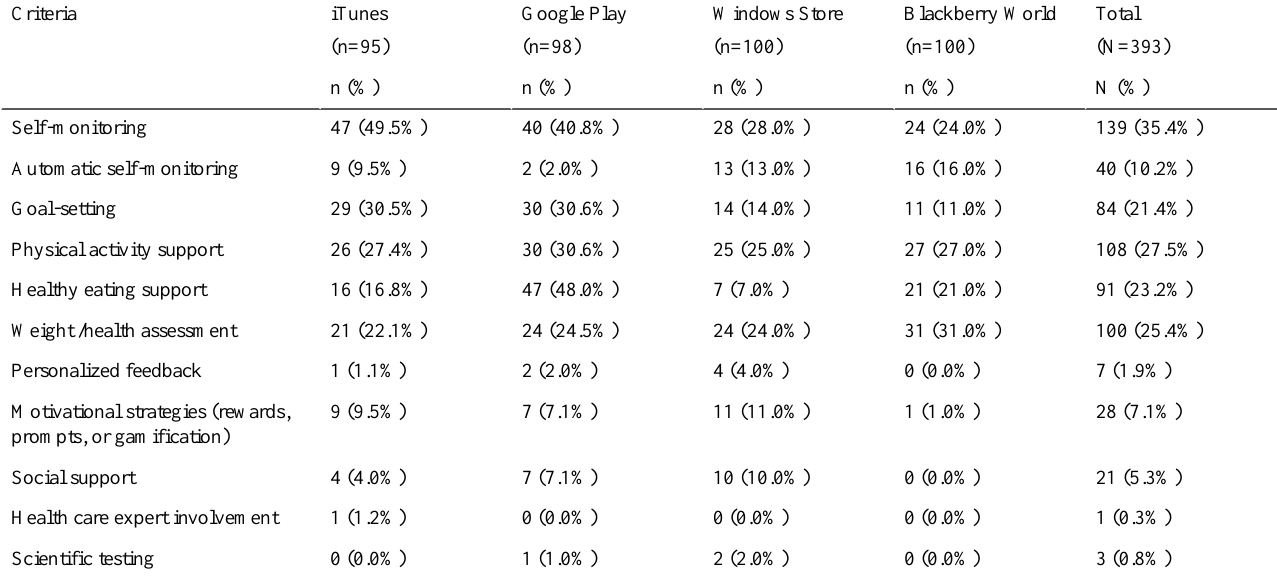
Table 1. Evidence-based strategies, health care expert involvement, and scientific testing in apps for weight